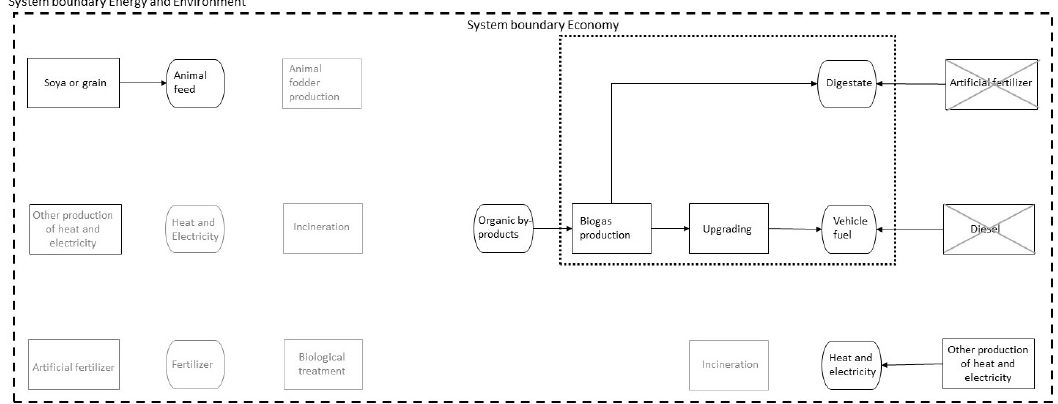
Figure 3. Scenario CHP, produced biogas is incinerated to generate heat and electricity and fertilizer is produced. The dotted line shows the system boundary for the economic perspective and the crosshatched line shows the system boundary for the energy and environmental perspectives. The boxes in grey are not included in the scenario and the crossed boxes are the alternative treatment methods replaced. Energies 2018 , 11 , x FOR PEER REVIEW